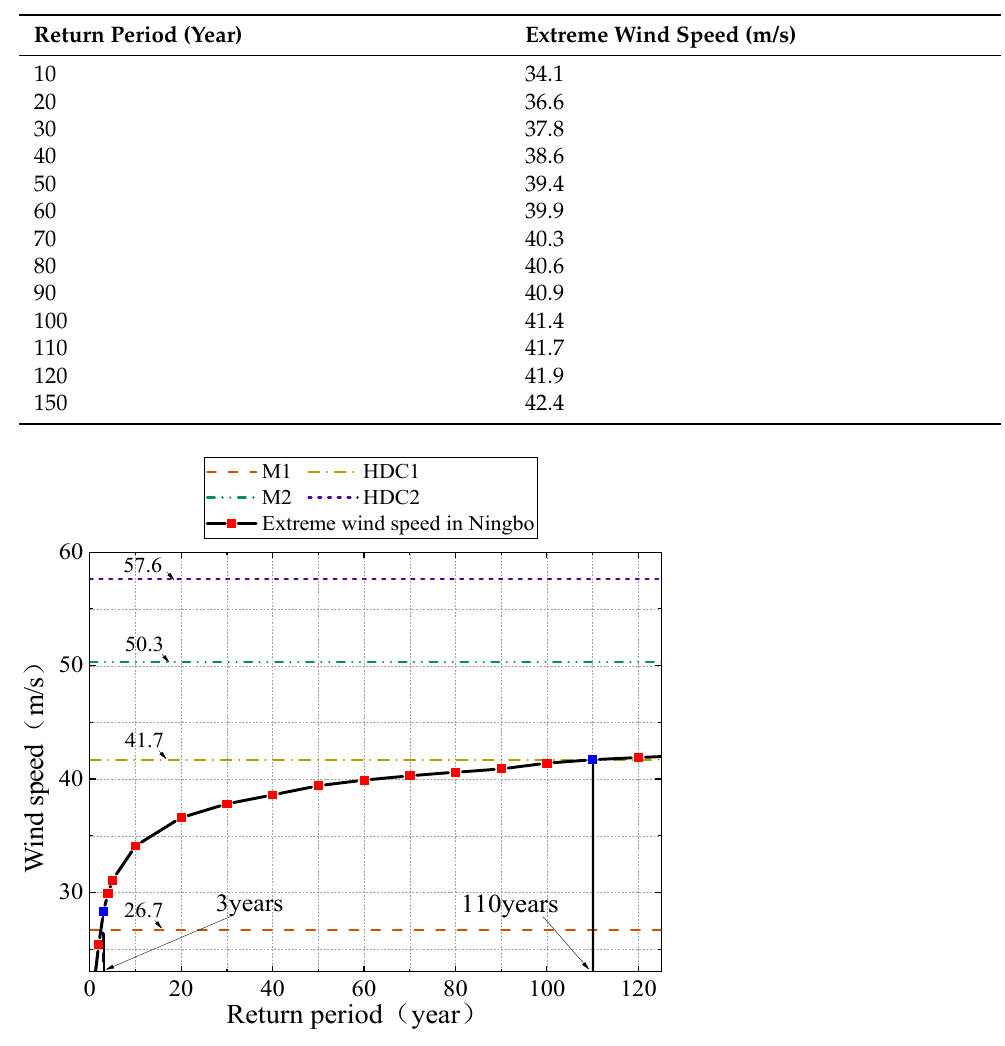
Figure 17. Maximum wind speed that the keel brick wall can withstand under different reinforcement schemes. Table 5. Extreme wind speeds in the most unfavorable wind direction (D2) corresponding to differ- ent return periods in Ningbo.